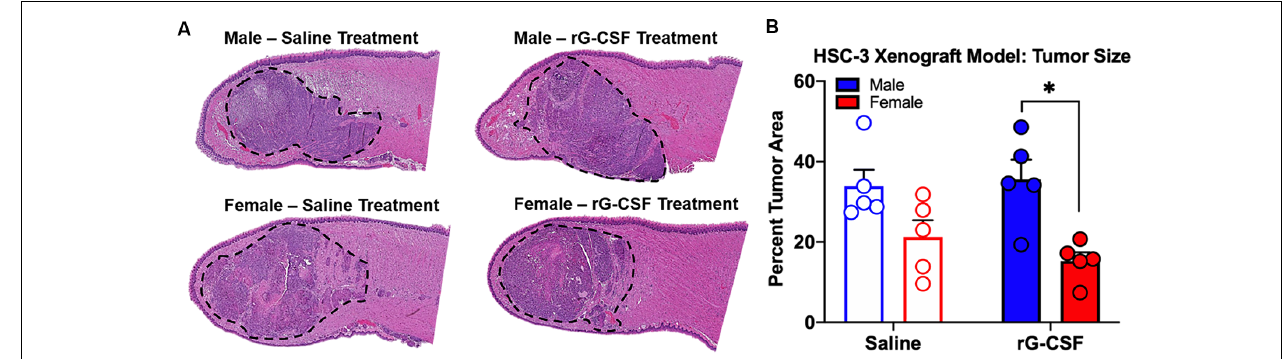
FIGURE 7 | HSC-3 xenograft tumor size was measured at PID 38. (A) Representative hematoxylin and eosin-stained sagittal tongue sections (100 µ m from center) from male (top) and female (bottom) mice treated with either saline or rG-CSF. HSC-3 tumor is outlined in black dash line. (B) Tumor area relative to total tongue area after treatment with either saline ( N = 5/sex) or rG-CSF ( N = 5/sex) in male and female mice. Two-way ANOVA, ∗ P <